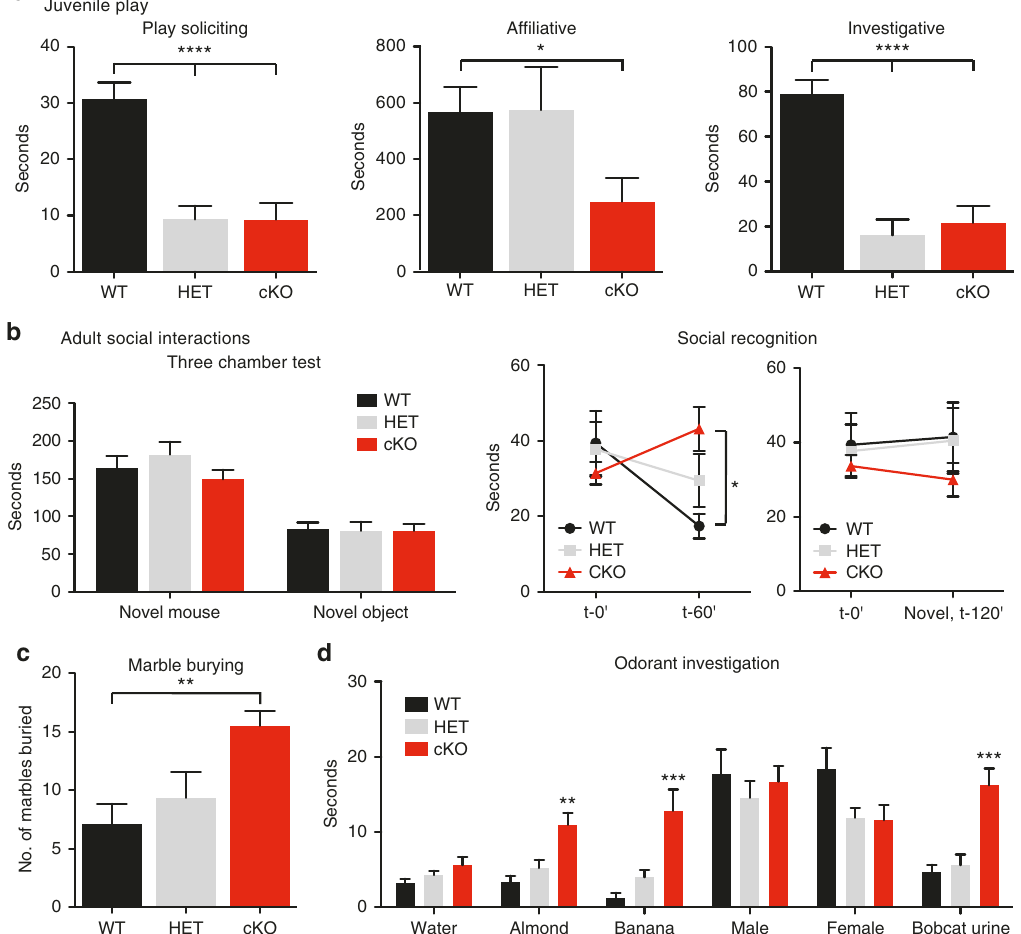
Fig. 2 The NHE9 cKO exhibits behavioral features characteristic of ASD. a Postnatal day 21 (P21) mice were videotaped for 30 min and the amount of time soliciting play, in af fi liative and investigative behavior, were scored. **** p < 0.0001 by one-way ANOVA with Bonferroni multiple comparison. * p = 0.016 by two-tailed Student ’ s t test comparing WT and cKO animals. WT, n = 12; HET, n = 10; cKO, n = 11. b Adult NHE9 cKO mice show selective defects in social interaction. Left panel, the three chamber test shows no difference between cKO and WT mice in the intrinsic interest of a novel mouse or novel object; all genotypes spend more time investigating a novel mouse. WT, n = 10; HET, n = 10; cKO, n = 12. Middle panel, NHE9 HET and cKO mice display de fi cits in social recognition. Total time spent investigating (snif fi ng, close following) a novel mouse (at t-0 ′ ) was compared with the time spent investigating the same mouse 1 h later (t-60 ′ , middle panel) or a novel mouse 2 h later (t-120 ′ , right panel). * p < 0.05 by two-way ANOVA with Bonferroni comparison. WT, n = 10; HET, n = 10; cKO, n = 10. c cKO mice exhibit repetitive digging behavior in the marble burying test. The number of marbles buried by each genotype was counted at the end of 30 min. ** p < 0.01 by one-way ANOVA with Bonferroni comparison. WT, n = 14; HET, n = 14; cKO, n = 21. d NHE9 cKO mice do not distinguish between social, non-social, or aversive odorant cues. ** p < 0.01, *** p < 0.001 by one-way ANOVA with Bonferroni comparison. WT, n